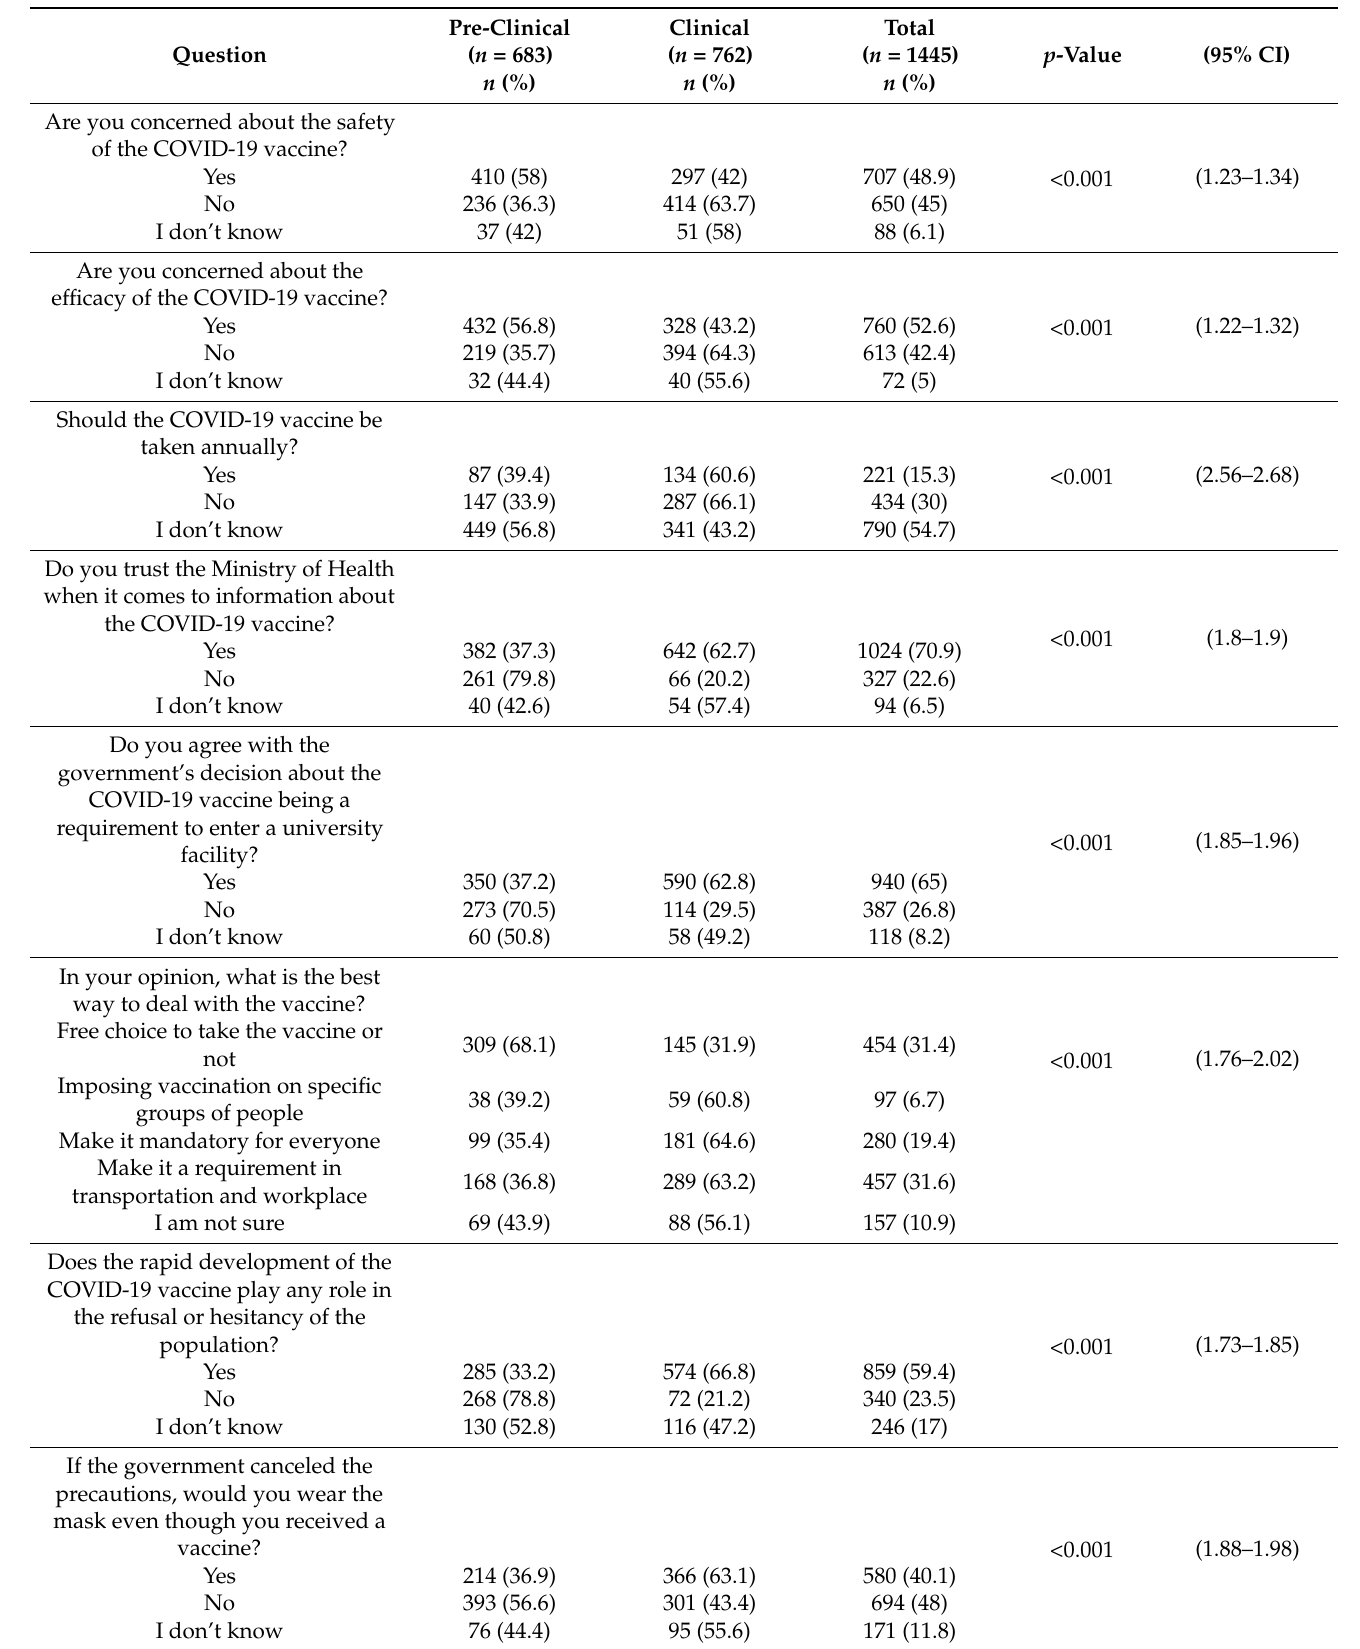
Table 3. Attitude related to COVID-19 vaccine and government’s decisions by pre-clinical/clinical